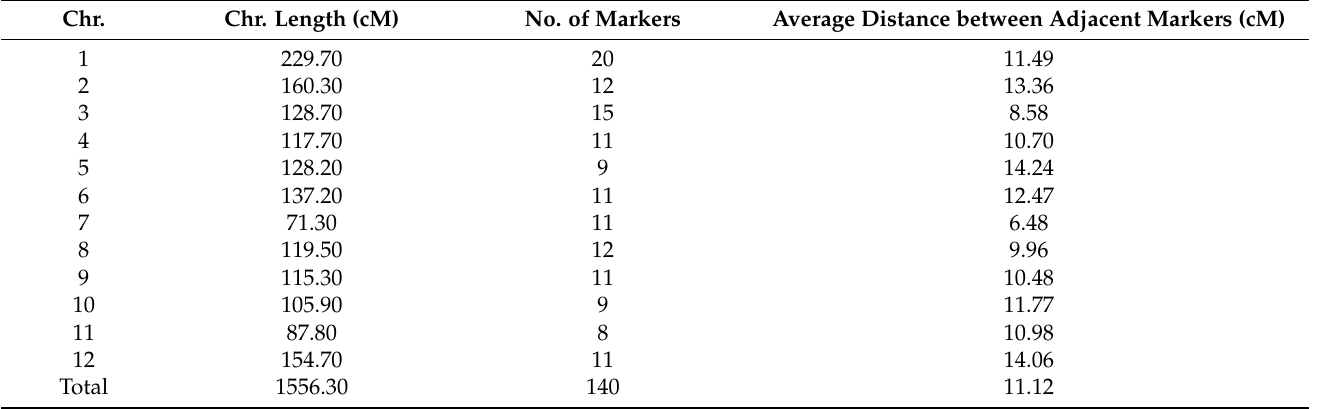
Table 1. Distribution of polymorphic markers on the 12 rice